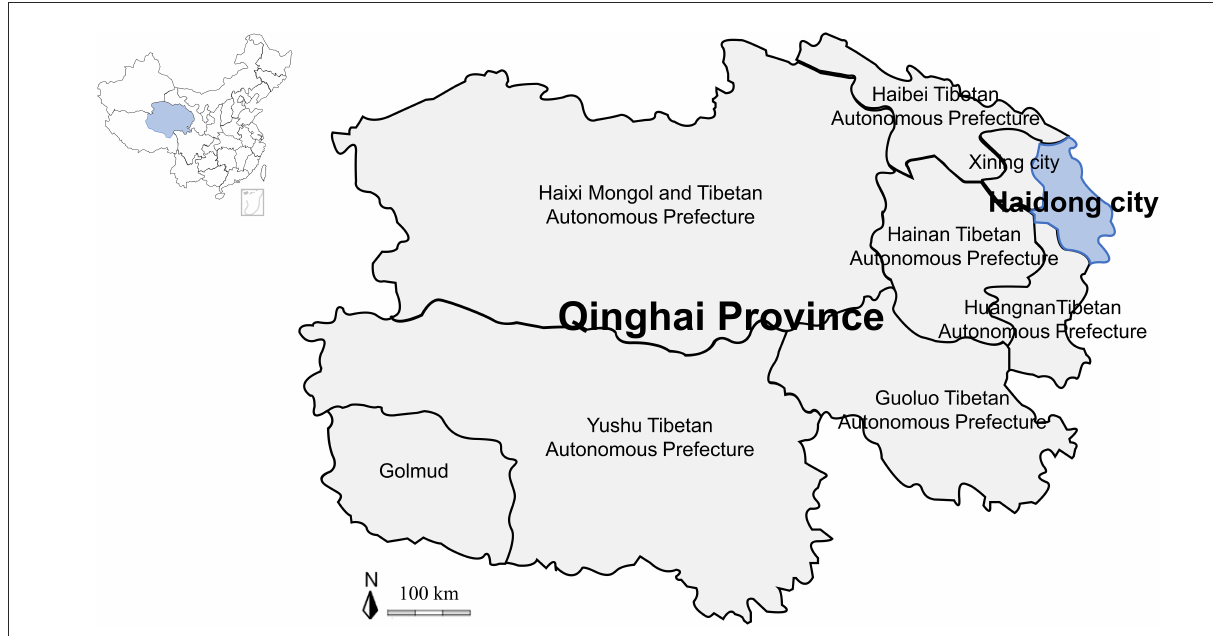
FIGURE1 Map of the Qinghai-Tibetan Plateau area and Qinghai Province showing the sampling area in this